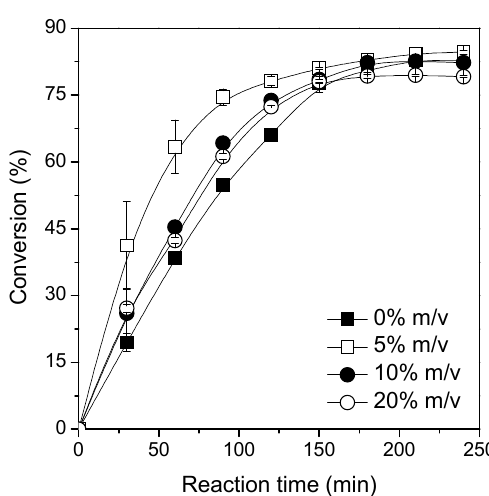
Figure 5. Effect of molecular sieves concentration on the ester synthesis. The reactions were performed at 56 °C, 240 rpm, acid:alcohol molar ratio 1:3, and biocatalyst concentration of 800 U of activity by using TLL–Octyl–SiO 2 as biocatalyst.